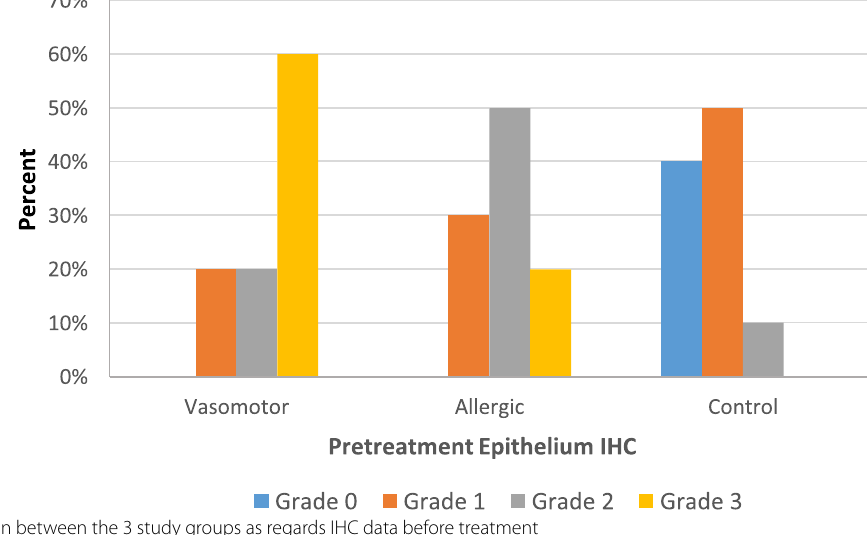
Fig. 6 Comparison between the 3 study groups as regards IHC data before treatment